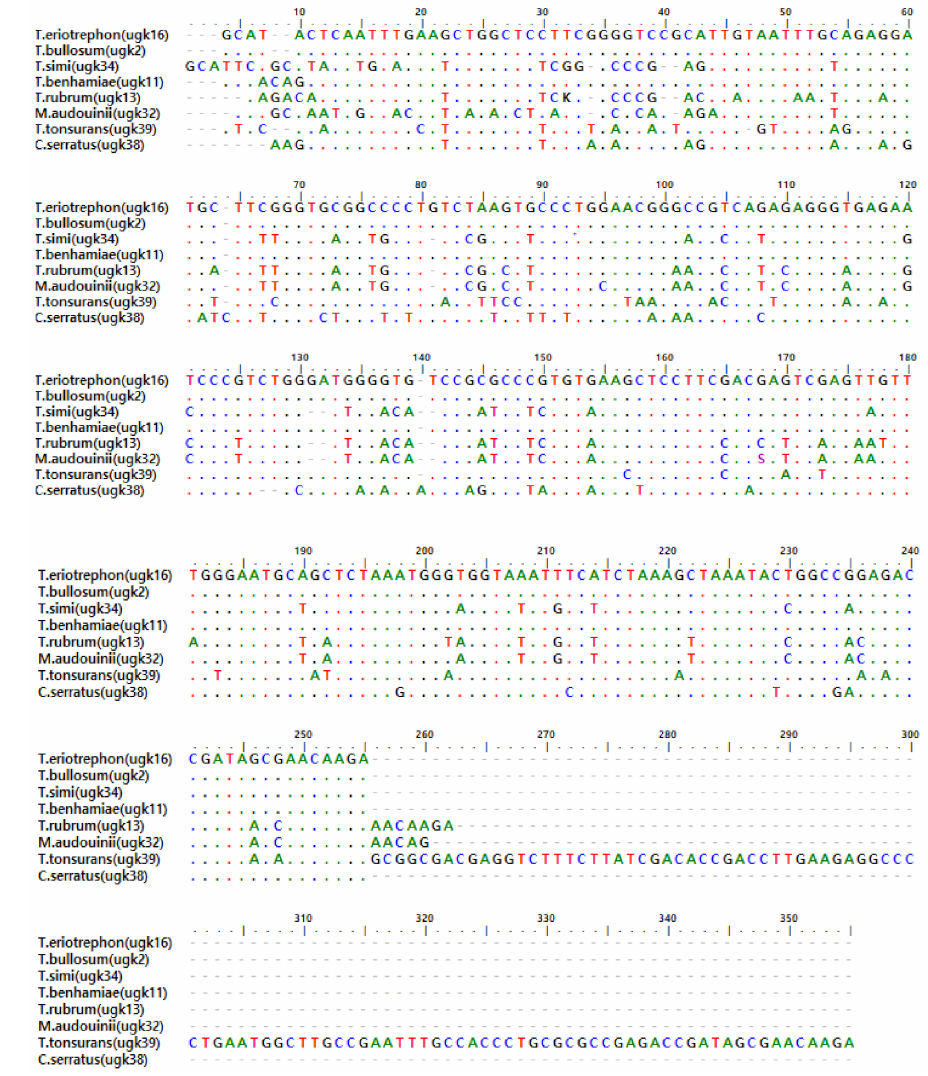
Figure 1. Multiple sequence alignment of eight (8) nucleotide sequences of the 28S rRNA gene of dermatophytes isolates from Sokoto. The coloured bases indicate regions of nucleotides diversity among isolates. The identical residues are represented with dots. The sequence layout is set to wrap at every 60 residues. Table 2. Clinical isolated species of dermatophytes used in this study for partial sequence analysis of the 28S rRNA gene, fragment size, and the range of intra-species variations and conserved regions within the species, are shown. Species (Tested Strain Number) LS (bp) Range of Intra-Species Variations Intra-Species Conserved Region T. eriotrephon